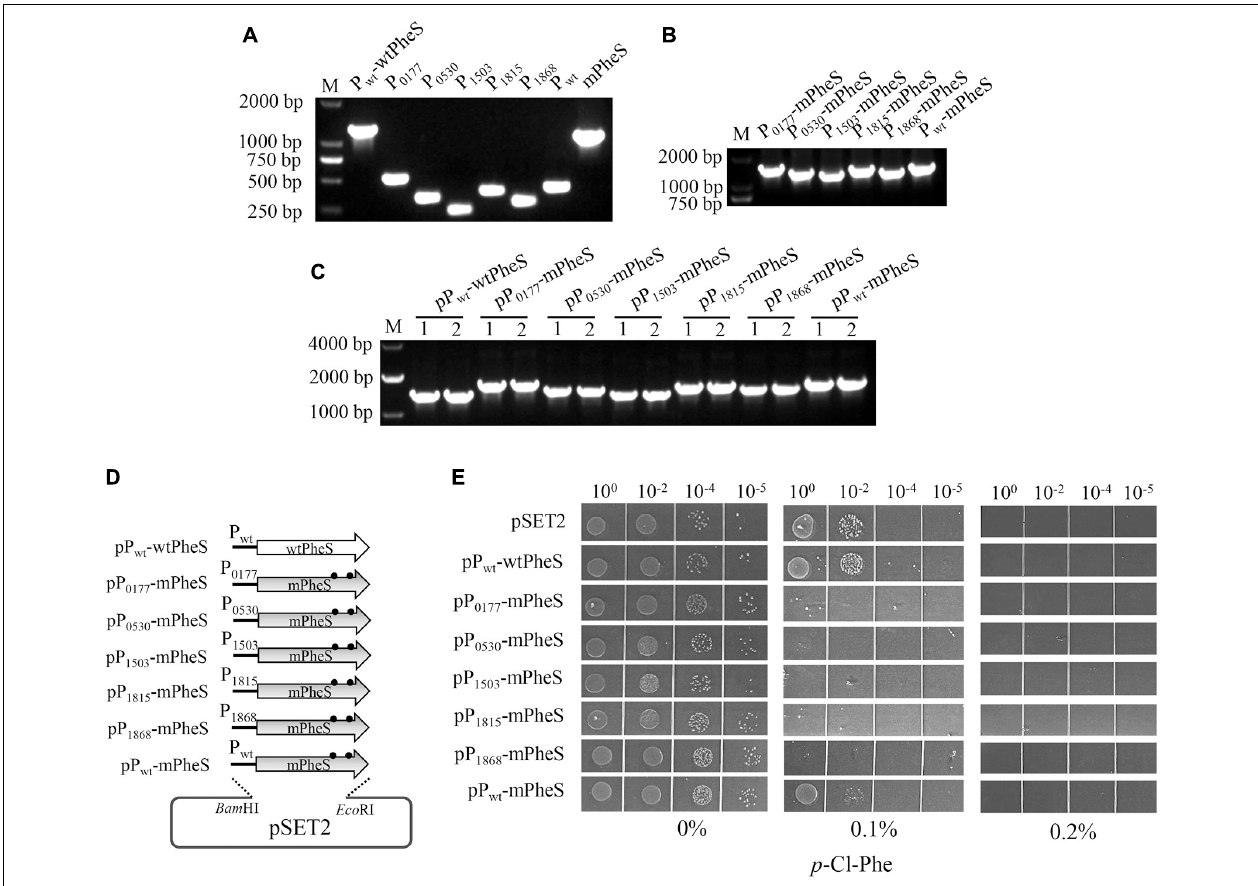
FIGURE 2 | Construction and growth inhibition test of S. suis strains with plasmid-carried P- mPheS cassettes. (A) Amplification of P wt - wtPheS , the six promoters (P 0177 , P 0530 , P 1503 , P 1815 , P 1868 , P wt ) and mPheS fragments. (B) Fused P- mPheS cassettes. (C) PCR confirmation of the S. suis transformants containing plasmid-carried P- mPheS cassettes (pP- mPheS ) with primers pSET2-F/pSET2-R. (D) Diagram for the constructed plasmids carrying P- mPheS cassettes. (E) Growth inhibition of pP- mPheS strains by the indicated concentrations of p